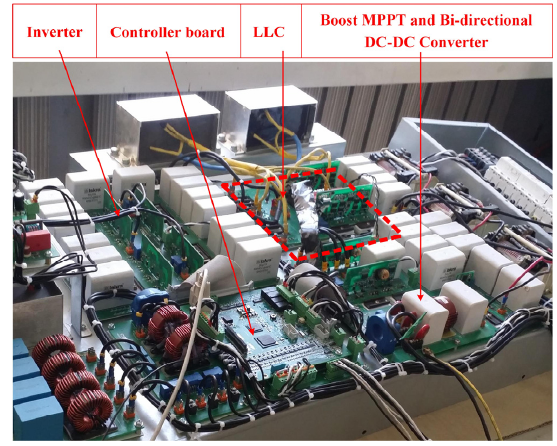
Figure 16. 7 kW residential photovoltaic system hardware setup.